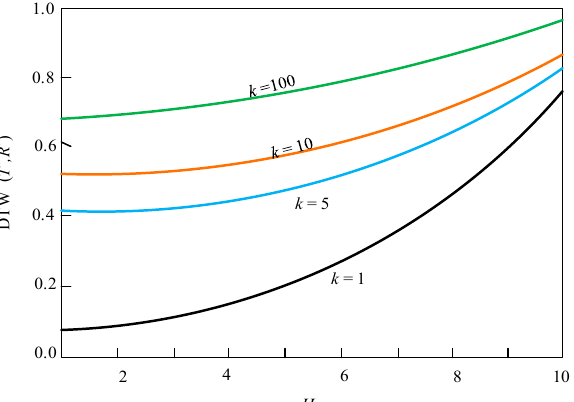
Figure 5. Relationship between DTW distance and the amplitude and frequency difference of zero-sequence current.